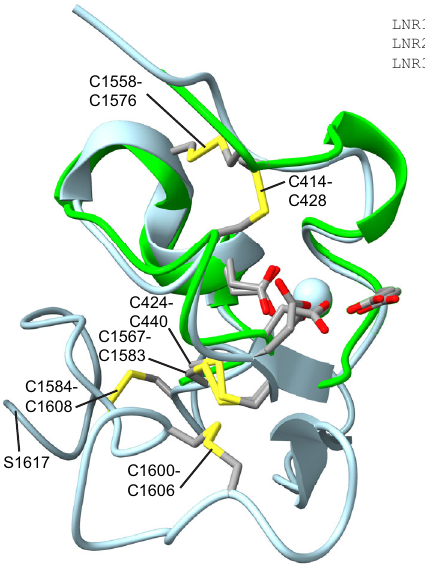
Fig.6|TheLin12-Notchrepeat(LNR)modulesofthePAPP-Asubunit.a Cartoon representation of PAPP-A LNR1 (green) and the C domain (light blue), including LNR3(darkgreen).LNR1andLNR3aresuperimposed.Disul fi debonds(yellow)and the positionofthetwoCa 2+ ions(spheres)are shown. b Sequence alignmentofthe three PAPP-A LNR modules emphasizing coordinating residues (highlighted in